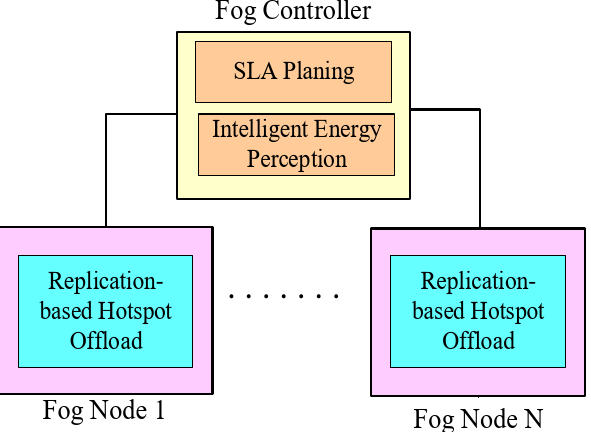
Figure 2. The framework of integrated resource management.